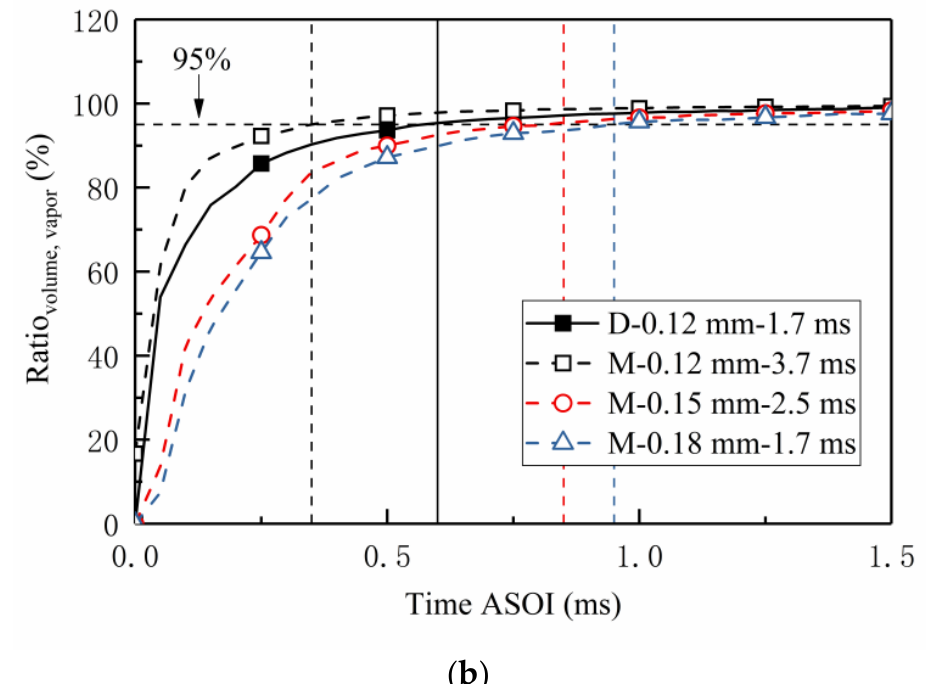
Figure 12. Comparison results of spray evaporating characteristics under different strategies. ( a ) Results of the liquid phase. ( b ) Volume fraction of the vapor phase.